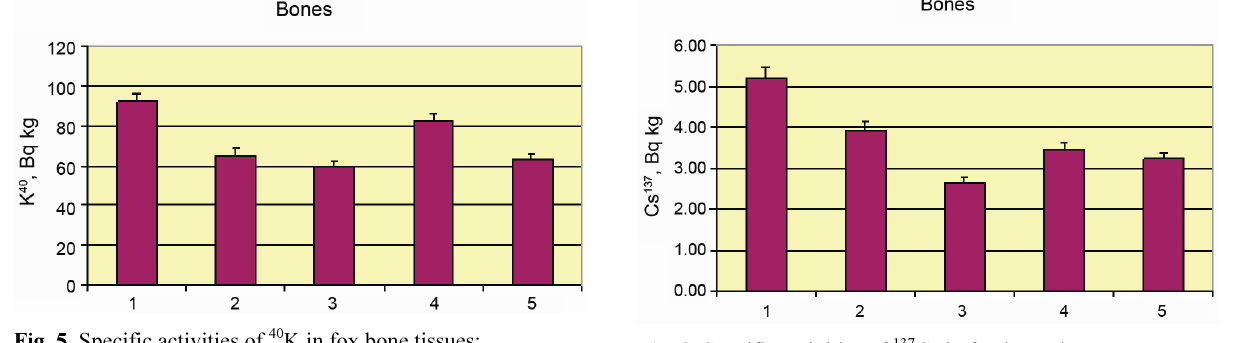
Fig. 5. Specific activities of